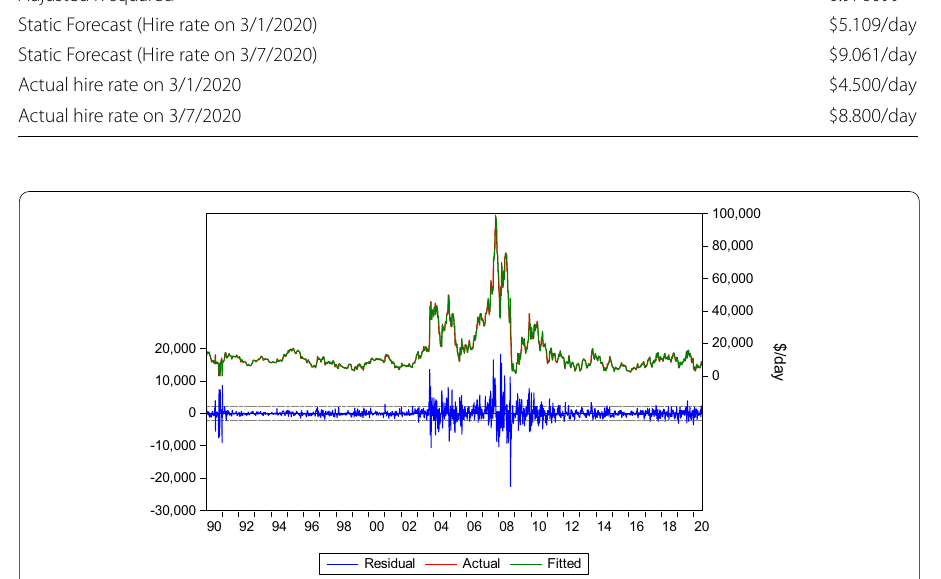
Fig. 8 Transpacific R/V 72.000 dwt. Source : Elaboration by the